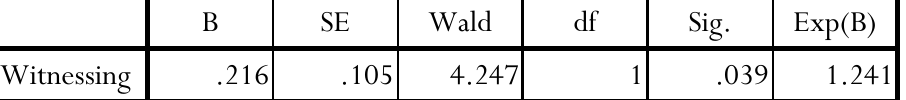
Table 13: Cox Regression of Number of Victimizations on Onset of Fighting